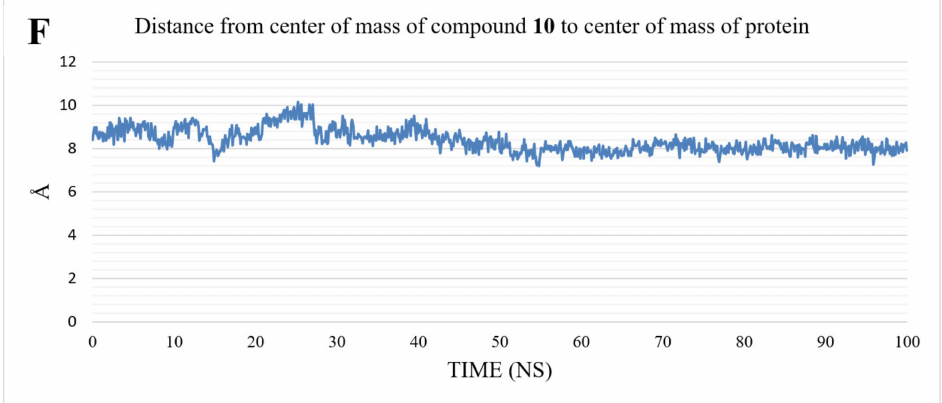
Figure 6. MD analysis. ( A ) RMSD. ( B ) RMSF. ( C ) SASA. ( D ) RoG. ( E ) H-bonding. ( F ) Change in the distance from the center of mass of the compound 10 -VEGFR-2 complex.